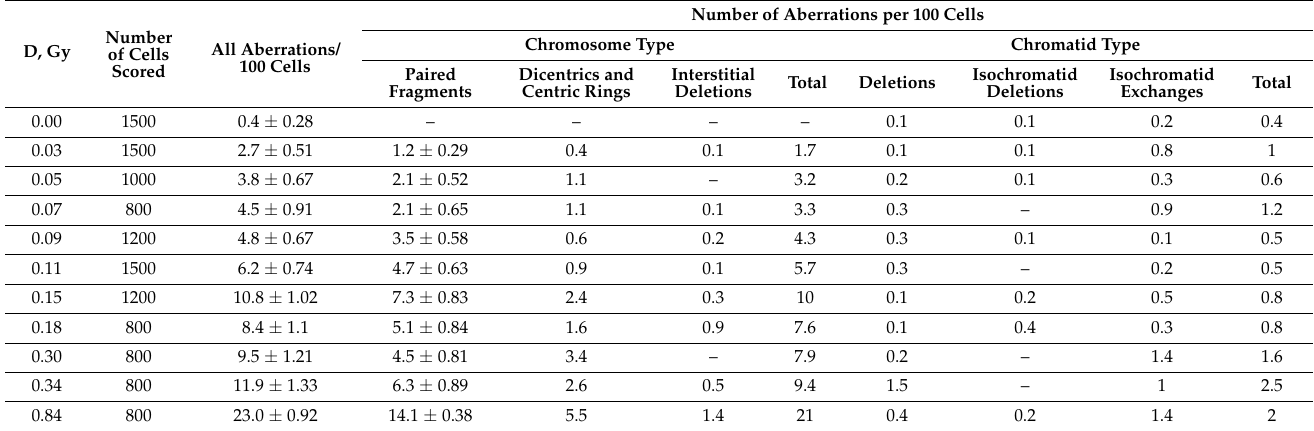
Table A3. Frequencies of chromosome aberrations induced in CHO-K1 cells by low doses of 14.5 MeV neutrons.